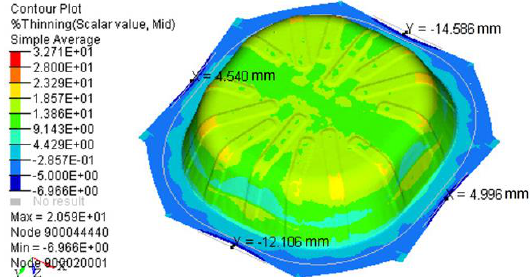
Figure 9. % Thinning distribution and X1, X2, Y1 and Y2 values for the RUN22; blank0. Metals 2019 , 9 , x FOR PEER REVIEW